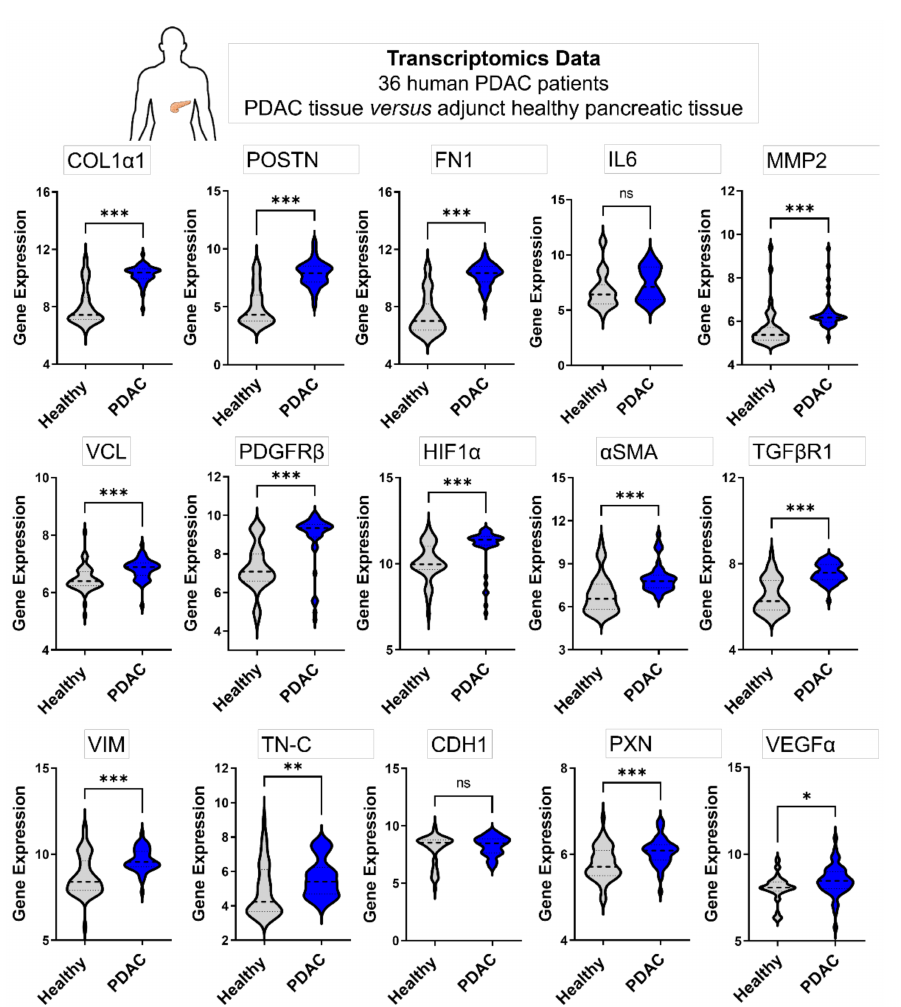
Figure 5. Comparative transcriptomic analysis in human PDAC patients. Gene expression in healthy adjunct pancreatic tissue and PDAC tissue from the same patient (36 PDAC patients in total). Statistical analysis was performed by two-tailed Student’s t -test. * p < 0.05, ** p < 0.01, *** p < 0.001.